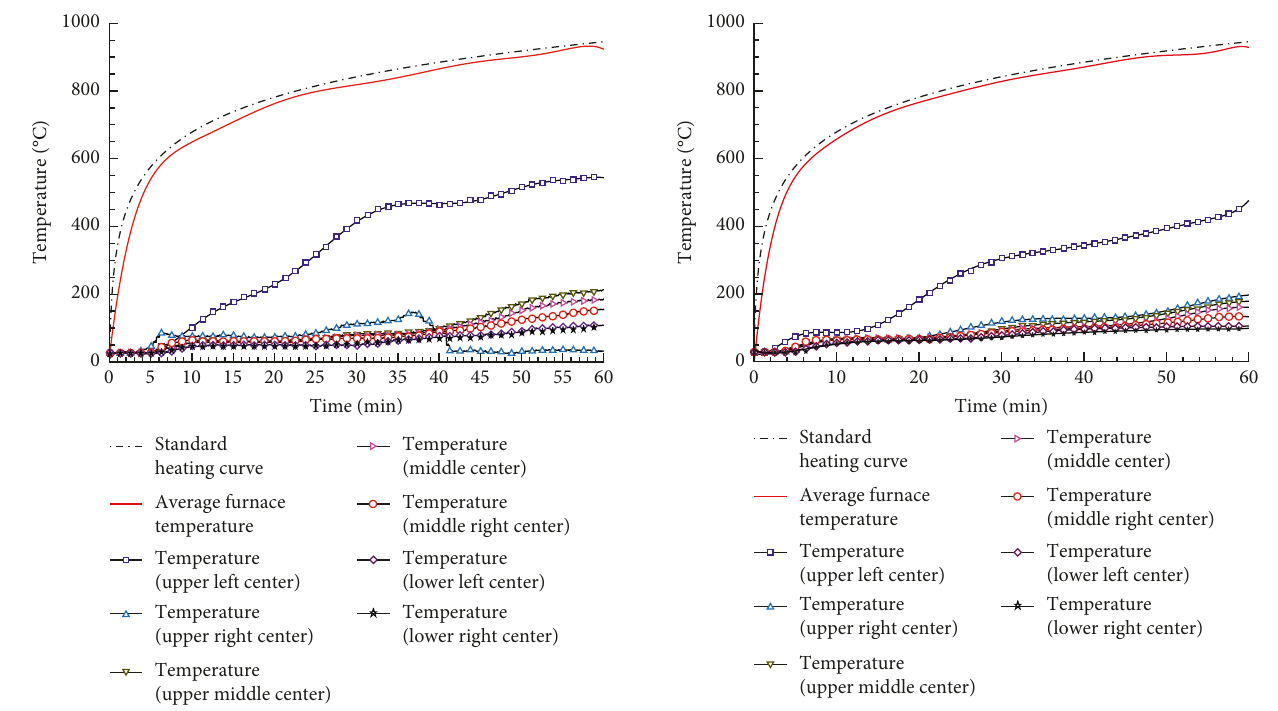
Figure 18: Time-temperature chart for the specimen in Test 3.